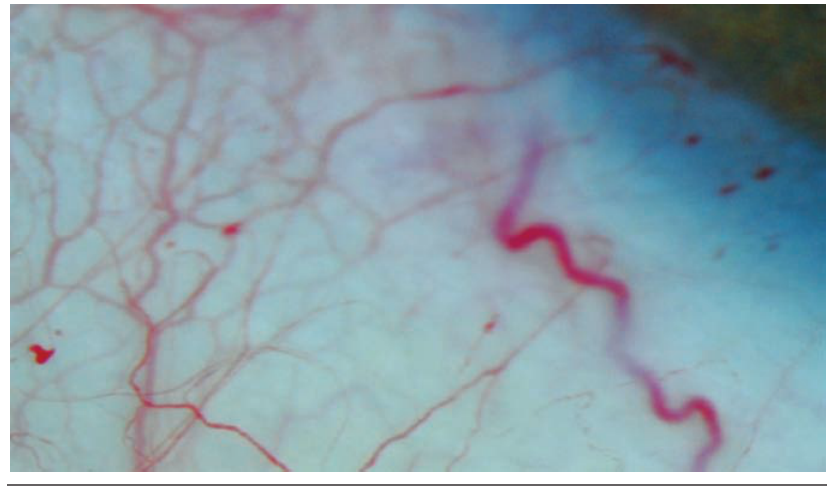
Figure 2. Microvascular abnormalities of the conjunctiva, such as these aneurysms, occur